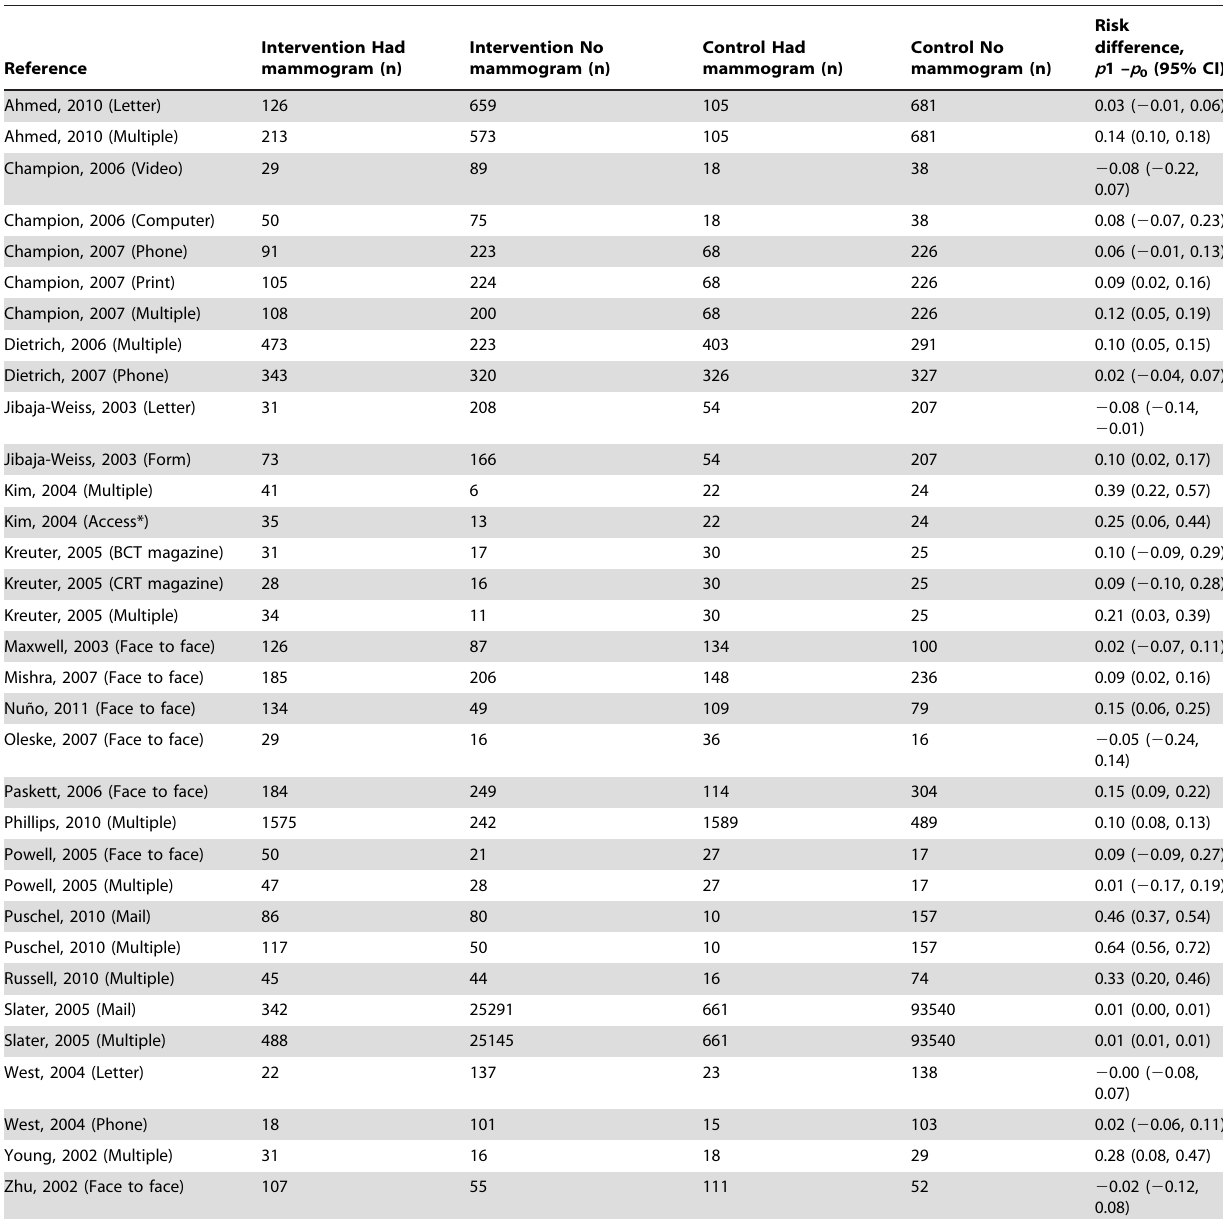
Table 3. Results of studies included in the